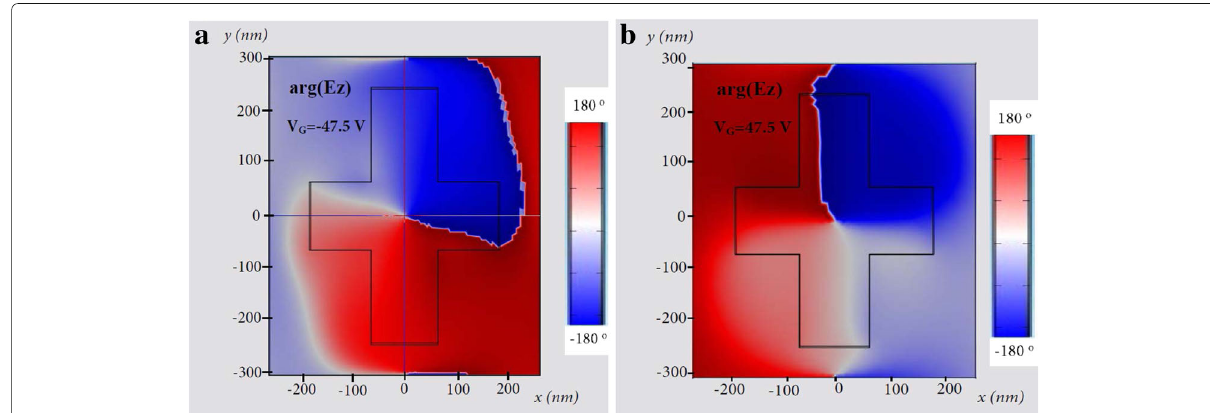
Fig. 8 Phase map of electric field component E z through the silicon/graphene cross-shaped structure at z = 0 calculated at the design wavelength λ = 1.5 μ m, a when the gate voltage is V G = − 47.5 V , and b when the gate voltage is V G = 47.5 V